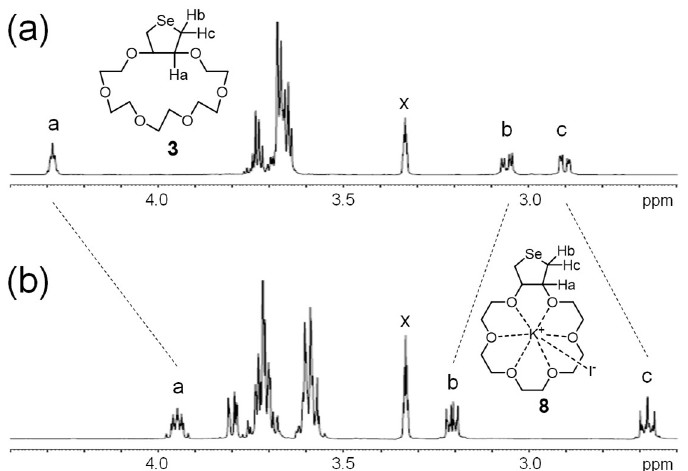
Figure 3. 500 MHz 1 H NMR spectra for 3 in CD 3 OD. ( a ) In the absence of KI. ( b ) After the addition of 1 eq of KI. “x” indicates the solvent peak.